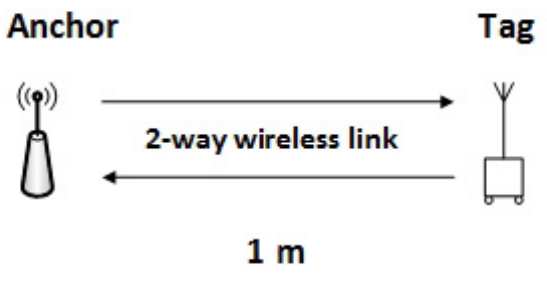
Figure 1. Experimental setup with one anchor and one mobile tag in clear line of sight